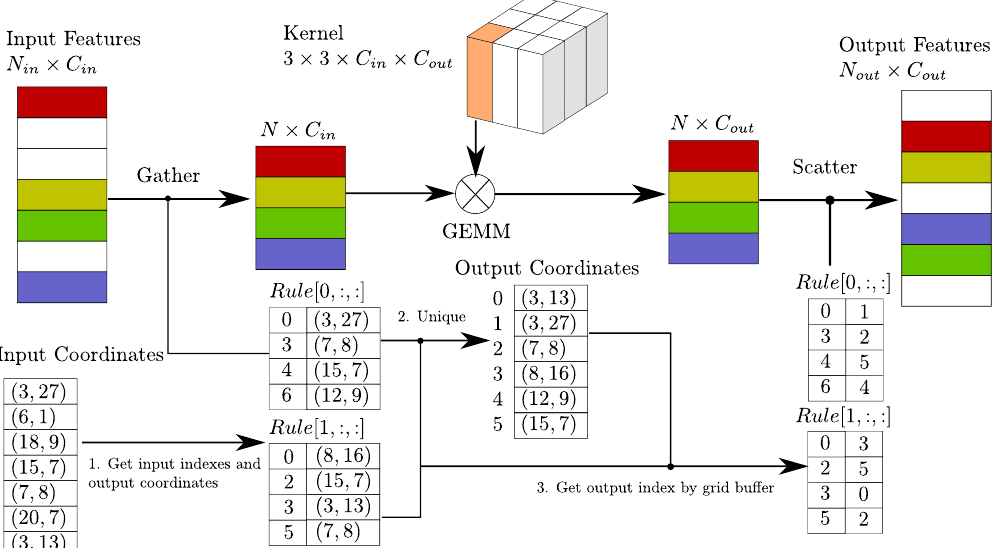
Figure 2. The sparse convolution algorithm is shown above, and the GPU rule generation algorithm is shown below. N in denotes the number of input features, and N out denotes the number of output features. N is the number of gathered features. Rule is the rule matrix, where Rule [ i , :, : ] is the i -th rule corresponding to the i -th kernel matrix in the convolution kernel. The boxes with colors except white indicate points with sparse data and the white boxes indicate empty